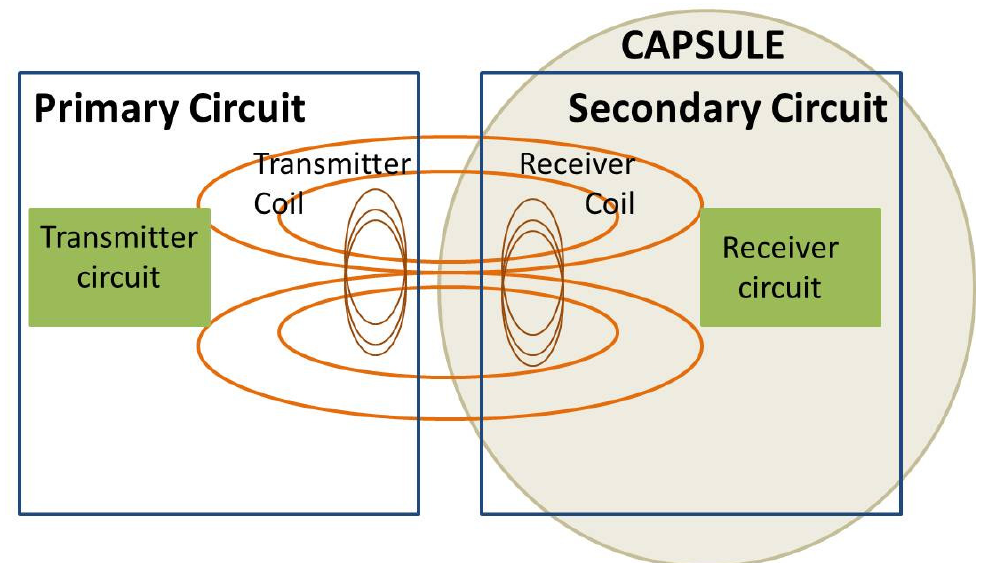
Figure 2. Schematic concept for wireless power recharging